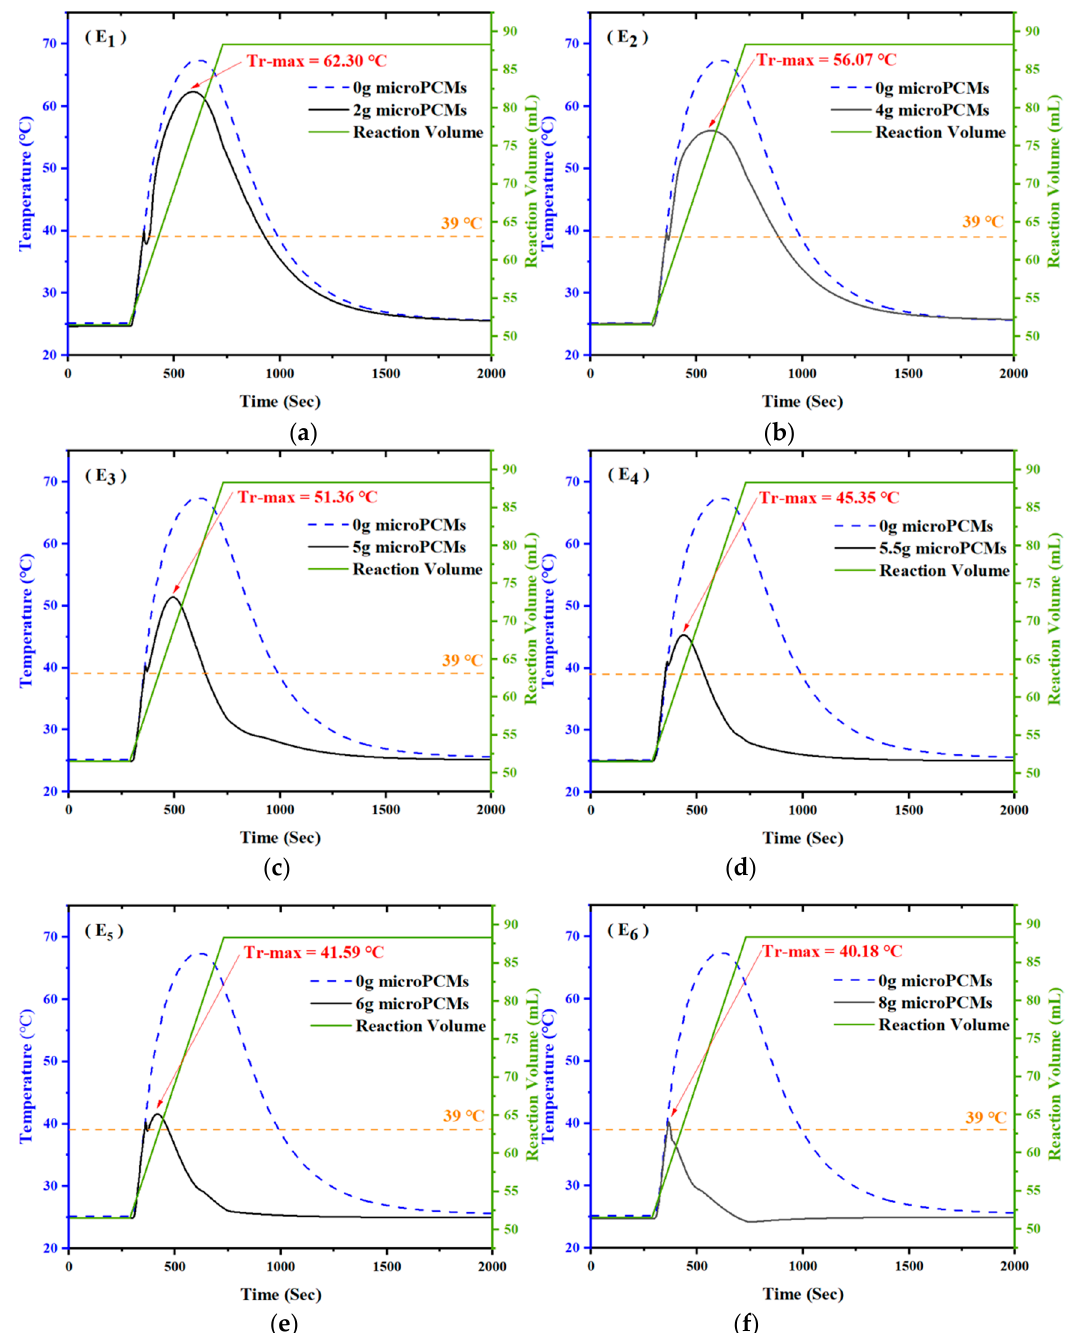
Figure 12. Experimental results with addition amount of ( a ) 2 g, ( b ) 4 g, ( c ) 5 g, ( d ) 5.5 g, ( e ) 6 g, ( f ) 8 g microPCMs at the temperature of 39 °C.